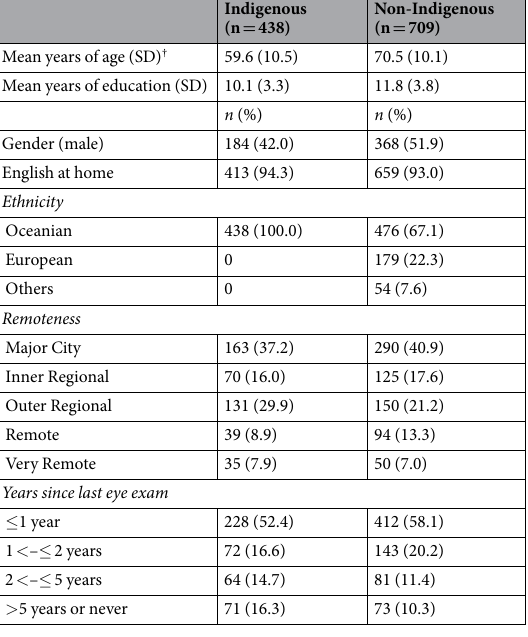
Table 1. Demographic characteristics of Indigenous and non-Indigenous Australians with unilateral or bilateral vision loss in the National Eye Health Survey. † Note the lower age limit for inclusion of Indigenous Australians than non-Indigenous